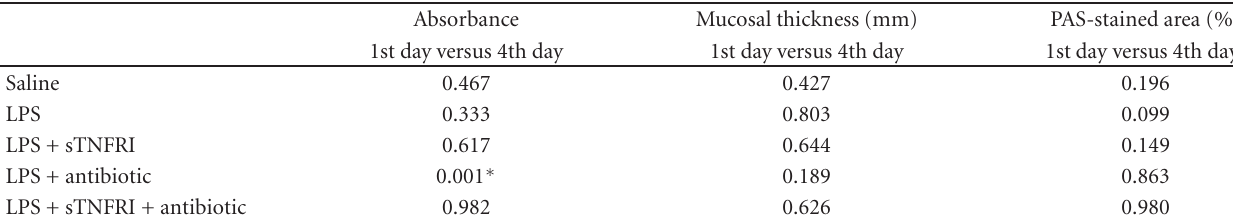
Table 2: Significance of di ff erences ( P value) in histopathological variables according to the time of